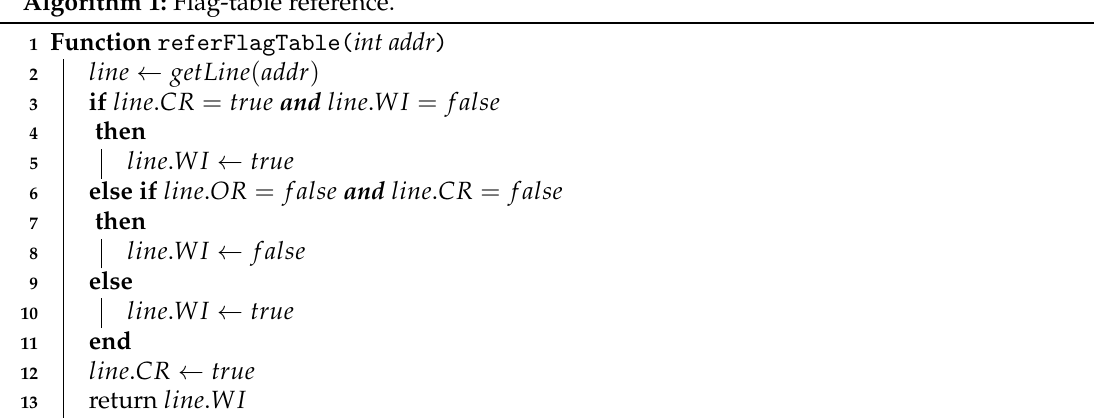
Algorithm 1: Flag-table